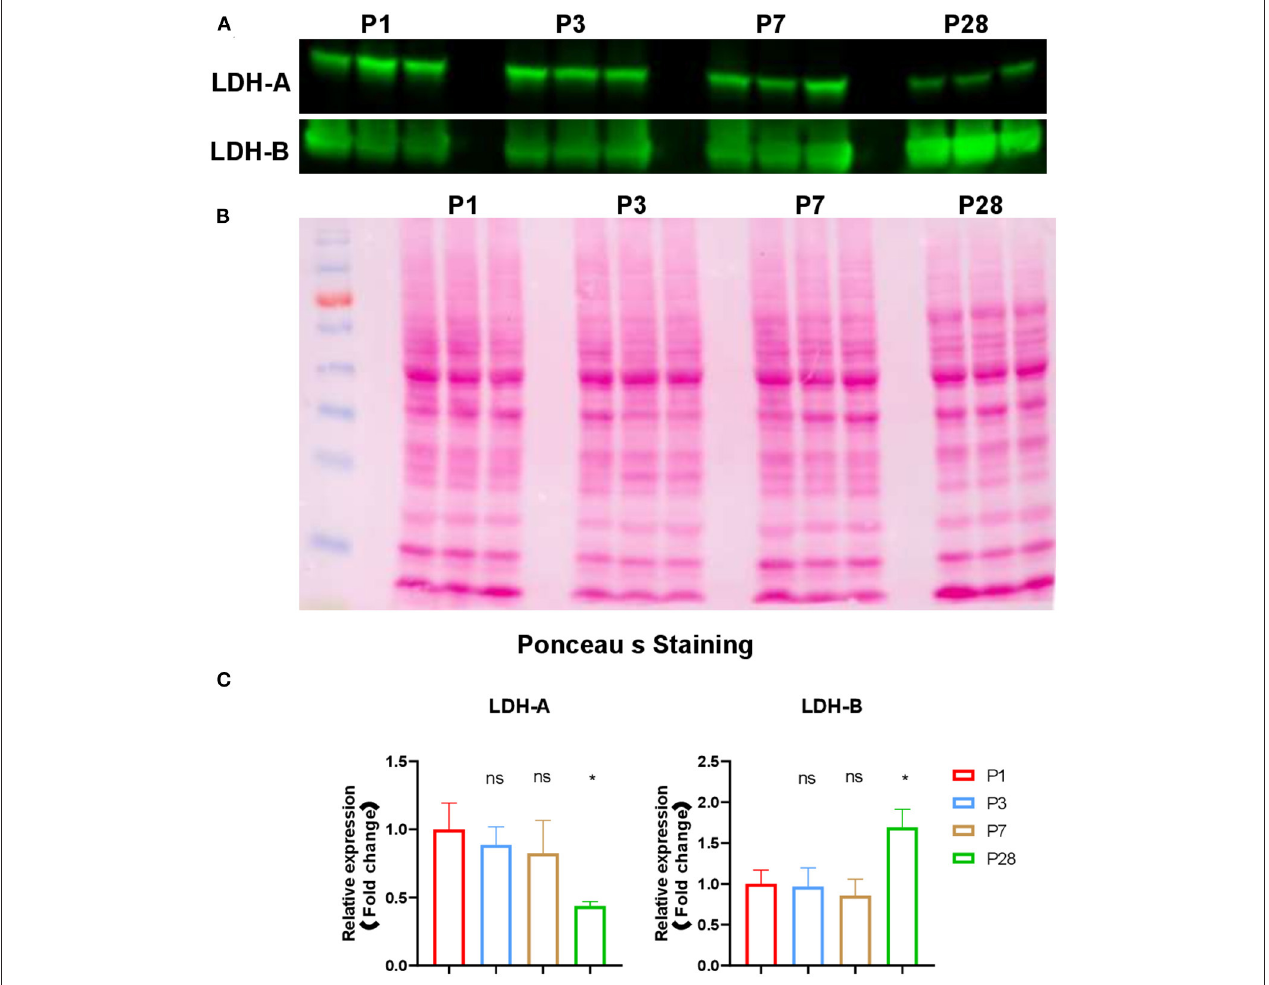
FIGURE 5 | Expression of LDHA and LDHB in neonatal pig hearts. (A) Western blot analysis of expression of LDHA and LDHB in in the four sets of heart samples (P1, P3, P7, and P28 hearts, n = 3 hearts per age). (B) Ponceau S staining of the blot to confirm equal protein loading. (C) Quantification of band intensity by western blot via densitometric analysis. * p < 0.05; one-way ANOVA with Tukey’s Honestly Significant Difference